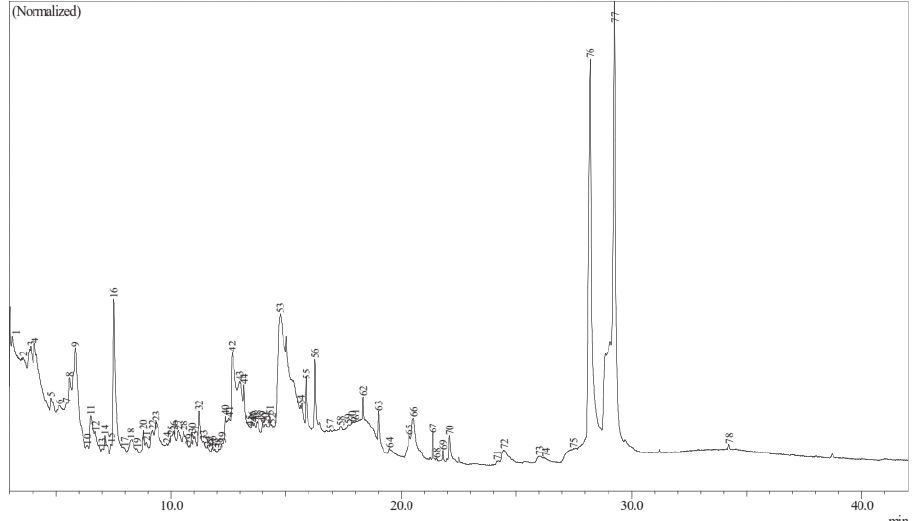
Figure 5. GCMS chromatogram of M. oleifera leaves methanol